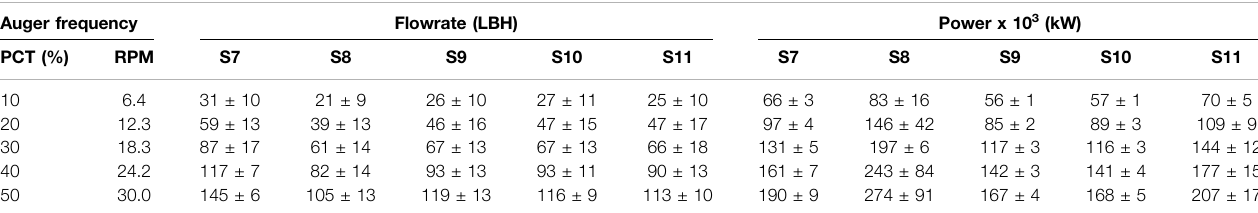
TABLE 6 | Summary of performance data for screw feeder in terms of fl owrate and power consumption. Auger